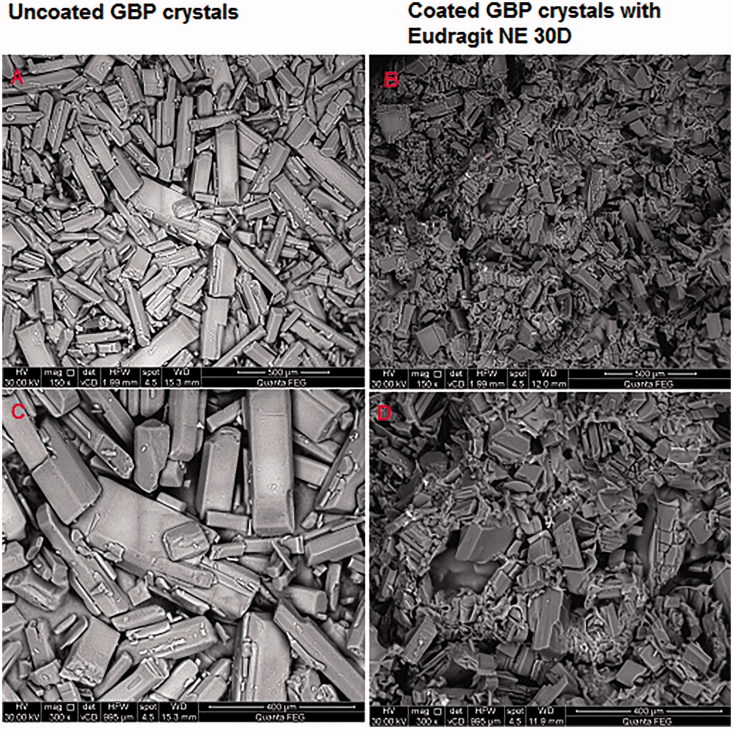
SEM of GBP pure drug crystals and GBP crystals coated with Eudragit NE 30D.